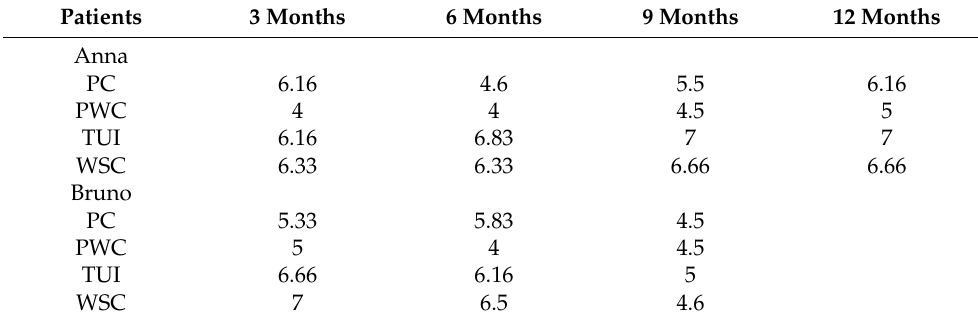
Table 3. CALPAS-P